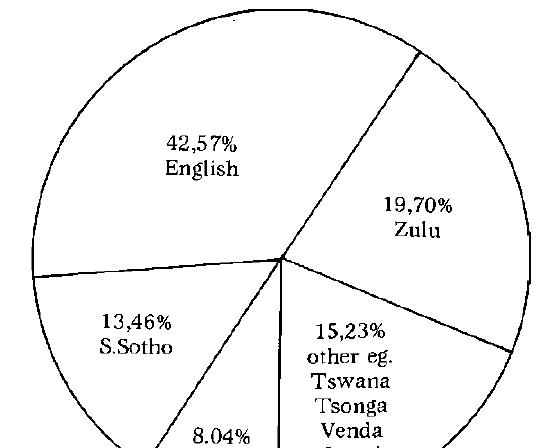
Figure 2: Enrolment according to medium of instruction in primary schools in DET for 1987* * Data obtained from DET Annual Report